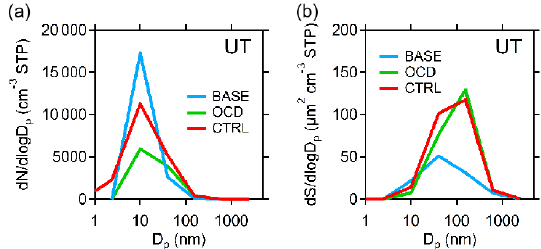
Figure A7. Simulated size distributions of (a) particle number con- centration, and (b) surface area in the upper troposphere (UT) along the flight tracks. The particle size distributions are normalized to